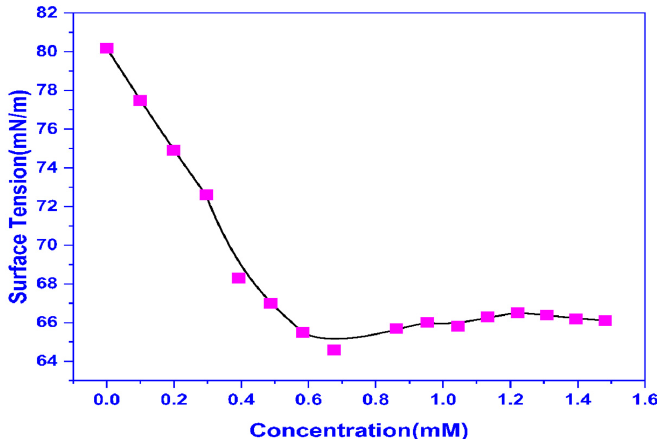
Figure 1. The plot of Surface tension vs. concentration.